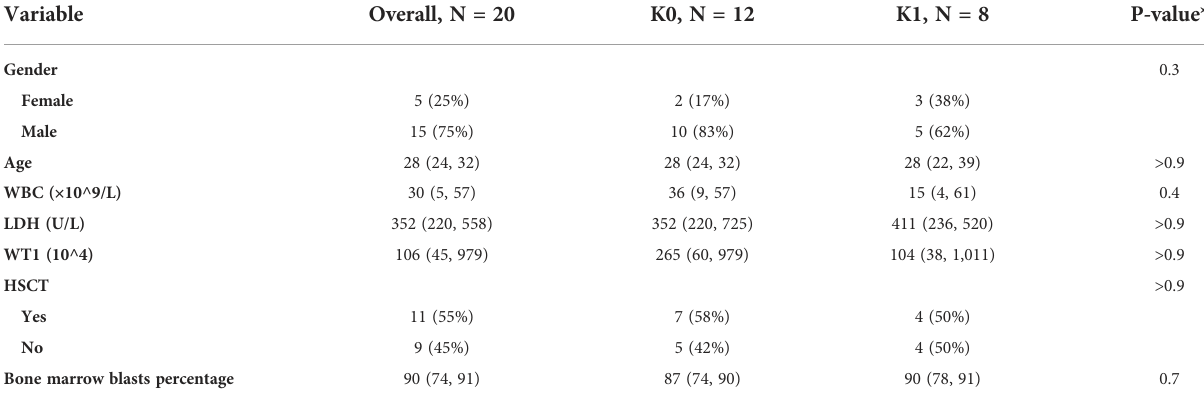
TABLE 1 Associations of survival subgroups with clinical covariates.